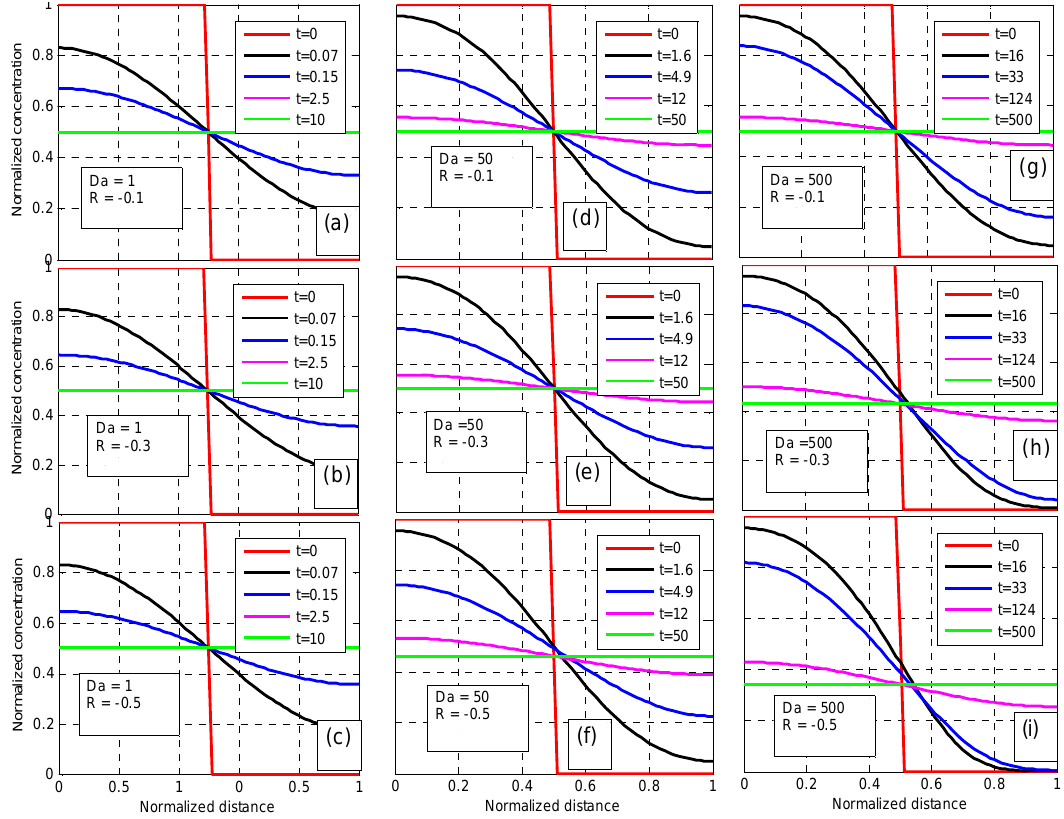
Figure 9. Profiles of normalized droplet concentration at different Da and at different R > − 1.